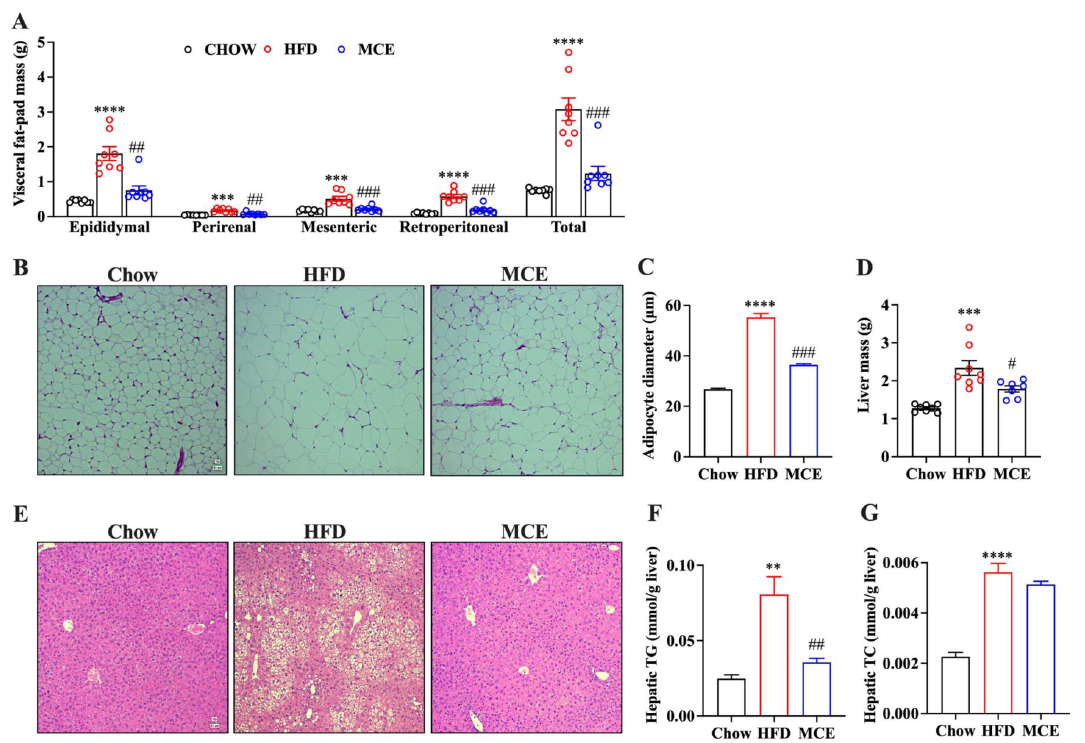
Figure 2. Effects of MCE on the hypertrophy of white adipose tissues (WAT) and hepatic steatosis in HFD-fed mice. ( A ) Visceral fat pad weights. ( B ) Representative images of H&E-stained sections of epididymal adipose tissue (100×). ( C ) Quantification of adipocyte diameter. ( D ) Liver mass. ( E ) Representative images of H&E-stained sections of liver tissue (100×). ( F ) Hepatic TG content. ( G ) Hepatic TC content. ** p < 0.01 versus chow group, *** p < 0.001 versus chow group, **** p < 0.0001 versus chow group; # p < 0.05 versus HFD group, ## p < 0.01 versus HFD group, ### p < 0.001 versus HFD group.